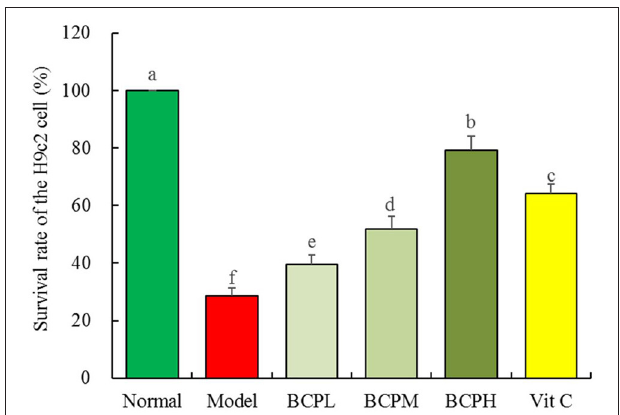
FIGURE 5 | Effect of BCP on survival rate of the H9c2 cell with OS injury. a − f Mean values with different letters over the bar are significantly different ( P < 0.05) according to Tukey’s honestly significant difference.